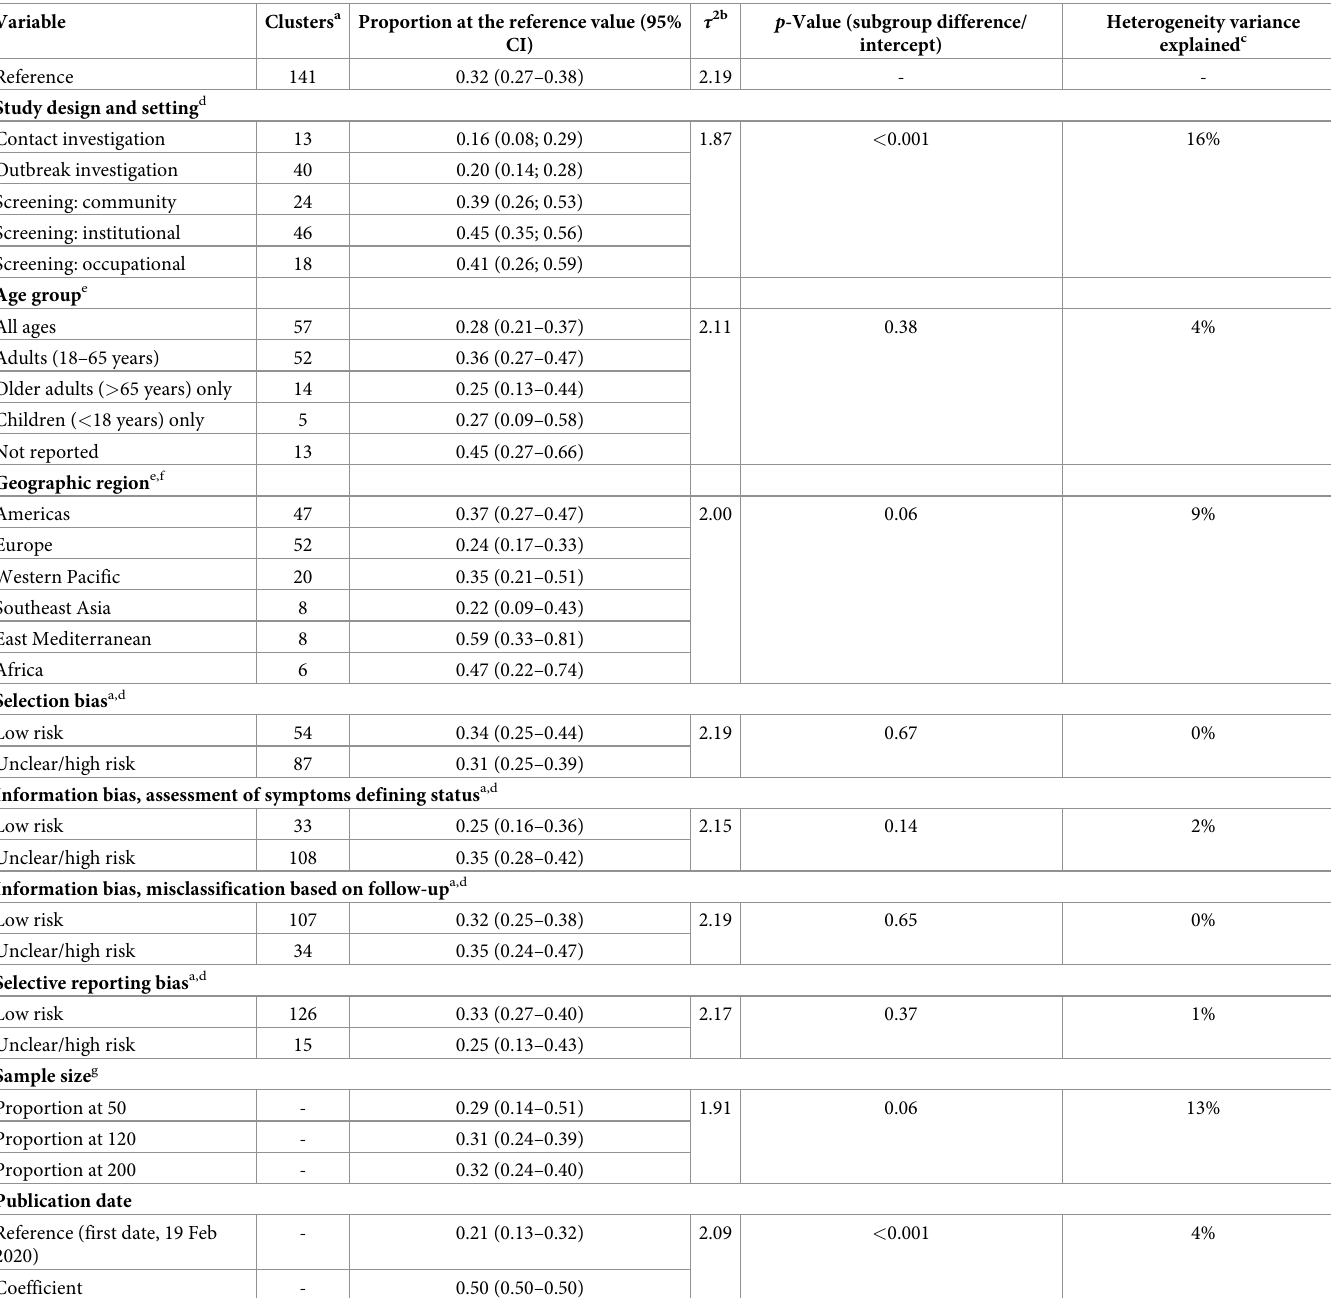
Table 2. Summary of findings of subgroup and meta-regression analyses of factors associated with the proportion of asymptomatic SARS-CoV-2 infections.